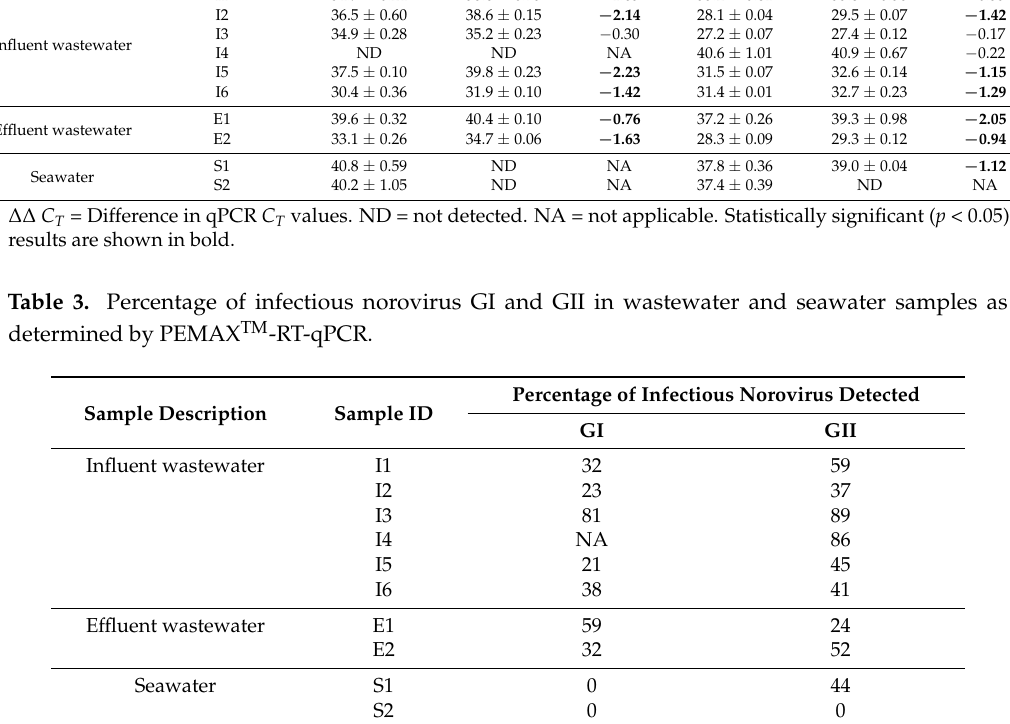
NA = Not applicable (as norovirus GI not detected by